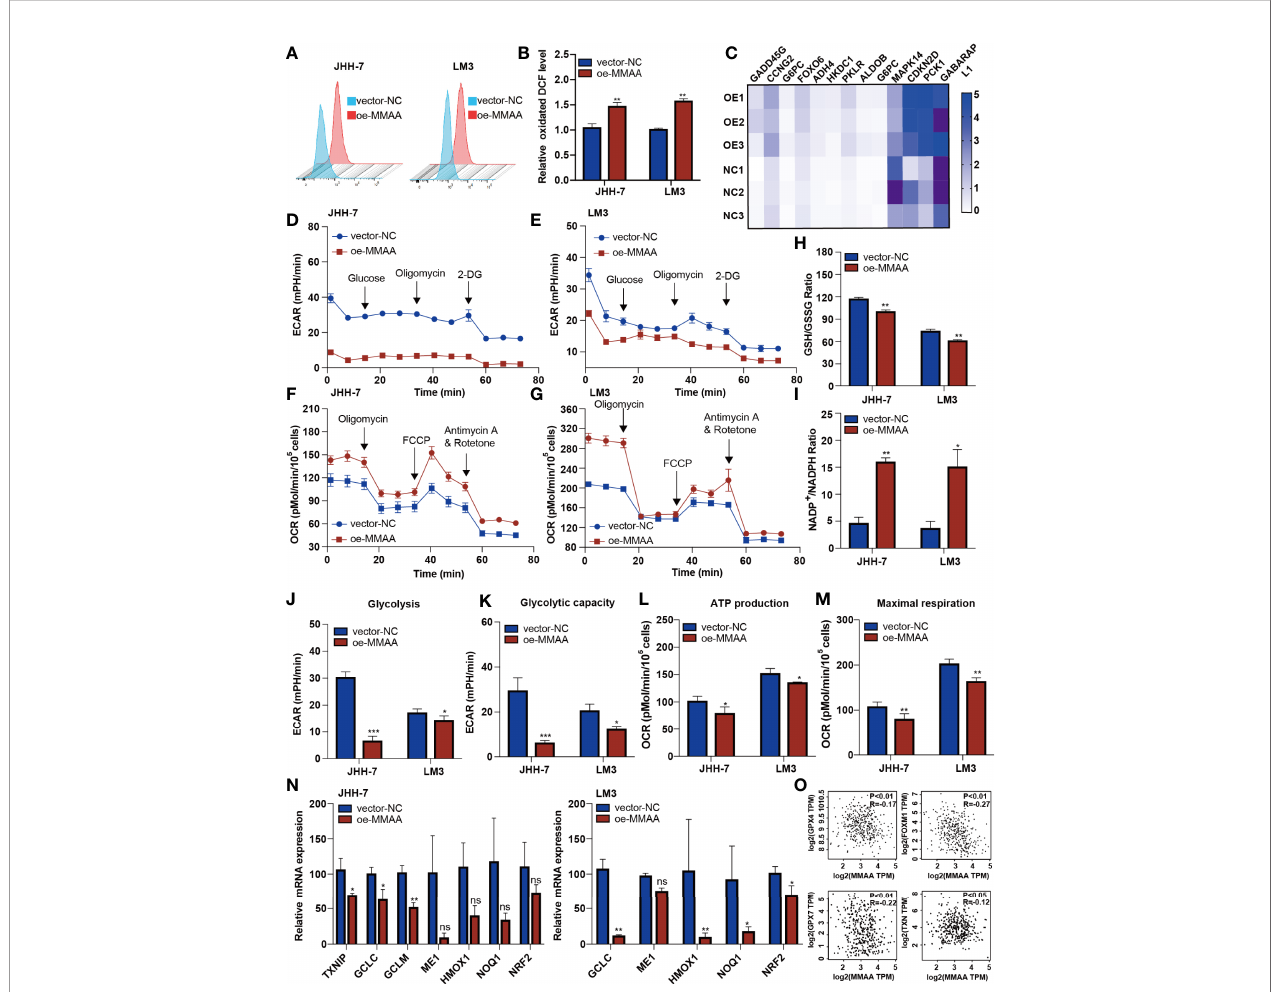
FIGURE 5 | Metabolism of cobalamin-associated A (MMAA) regulates redox balance to alter the mitochondrial function in hepatocellular carcinoma (HCC). (A) Reactive oxygen species (ROS) production was measured by fl ow cytometry in JHH-7 and LM3 cells with an overexpression of MMAA; quanti fi cation of ROS production is shown in (B) . (C) PCR array analysis of the effect of MMAA overexpression on changes in glycolysis and redox state related to mitochondrial function. (D, E) Overexpression of MMAA decreased the extracellular acidi fi cation rate in JHH-7 and LM3 cells; quanti fi cation of glycolysis and glycolytic capacity is shown in (J, K) . (F, G) Overexpression of MMAA increased the O 2 consumption rate in JHH-7 and LM3 cells; quanti fi cation of ATP production and maximal respiration is shown in ( L ) and (M) . (H) Determination of the GSH/ GSSG ratio in JHH-7 and LM3 cells overexpressing MMAA. (I) Determination of the NADP + /NADPH ratio in JHH-7 and LM3 cells overexpressing MMAA. (N) Quantitative PCR was performed to con fi rm that the mRNA expression of antioxidant response element-related genes was downregulated by an overexpression of MMAA. (O) Pearson ’ s correlation analysis of different genes expressed in HCC patients ’ tissues in the GEPIA2 dataset; MMAA expression was negatively correlated with GPX4 , FOXM1 , GPX7 , and TPM ( n = 369). * P < 0.05, ** P < 0.01, *** P < 0.001; three biological repeats per group. ns P >